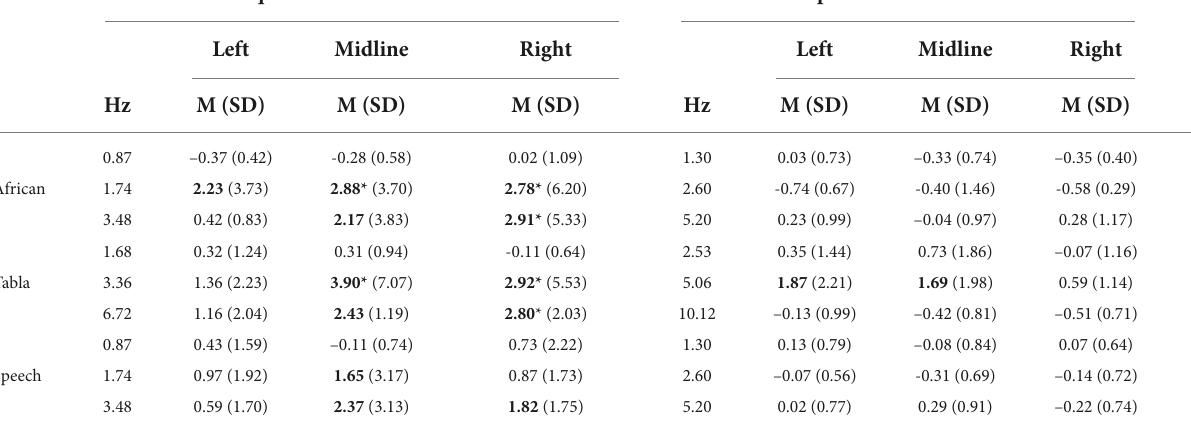
TABLE 2 Descriptive statistics for the adults’ data: Mean (Standard Deviation) on SS-EP magnitudes for frequencies of interest vs. noise floor separated for sound stimuli and cluster of channels. Peaks on the frequencies of interest Noise floor amplitudes Left Midline Right Left Midline